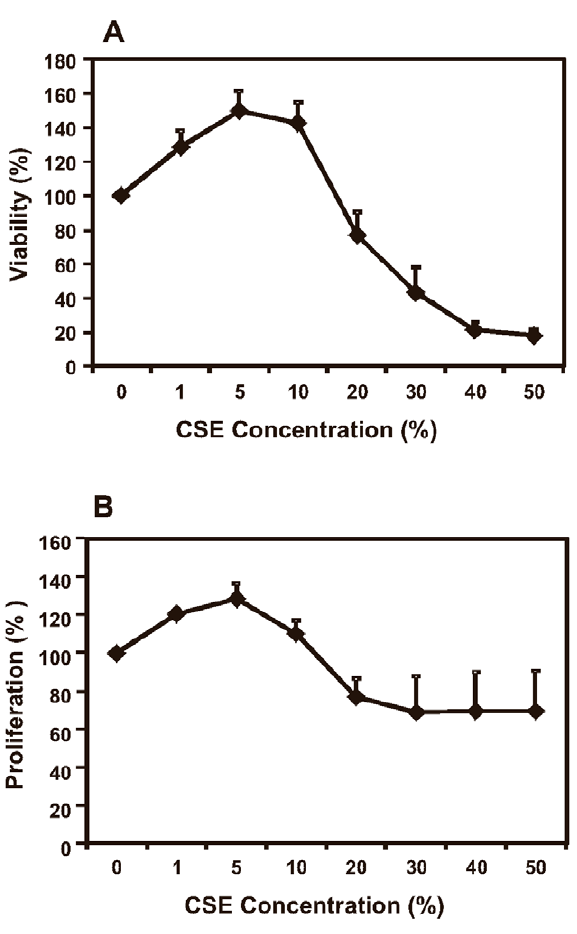
Figure 1. Viability and proliferation assays. B6Tert-1 cells (1 6 10 4 ) were seeded in a 96-well plate in triplicates and grown